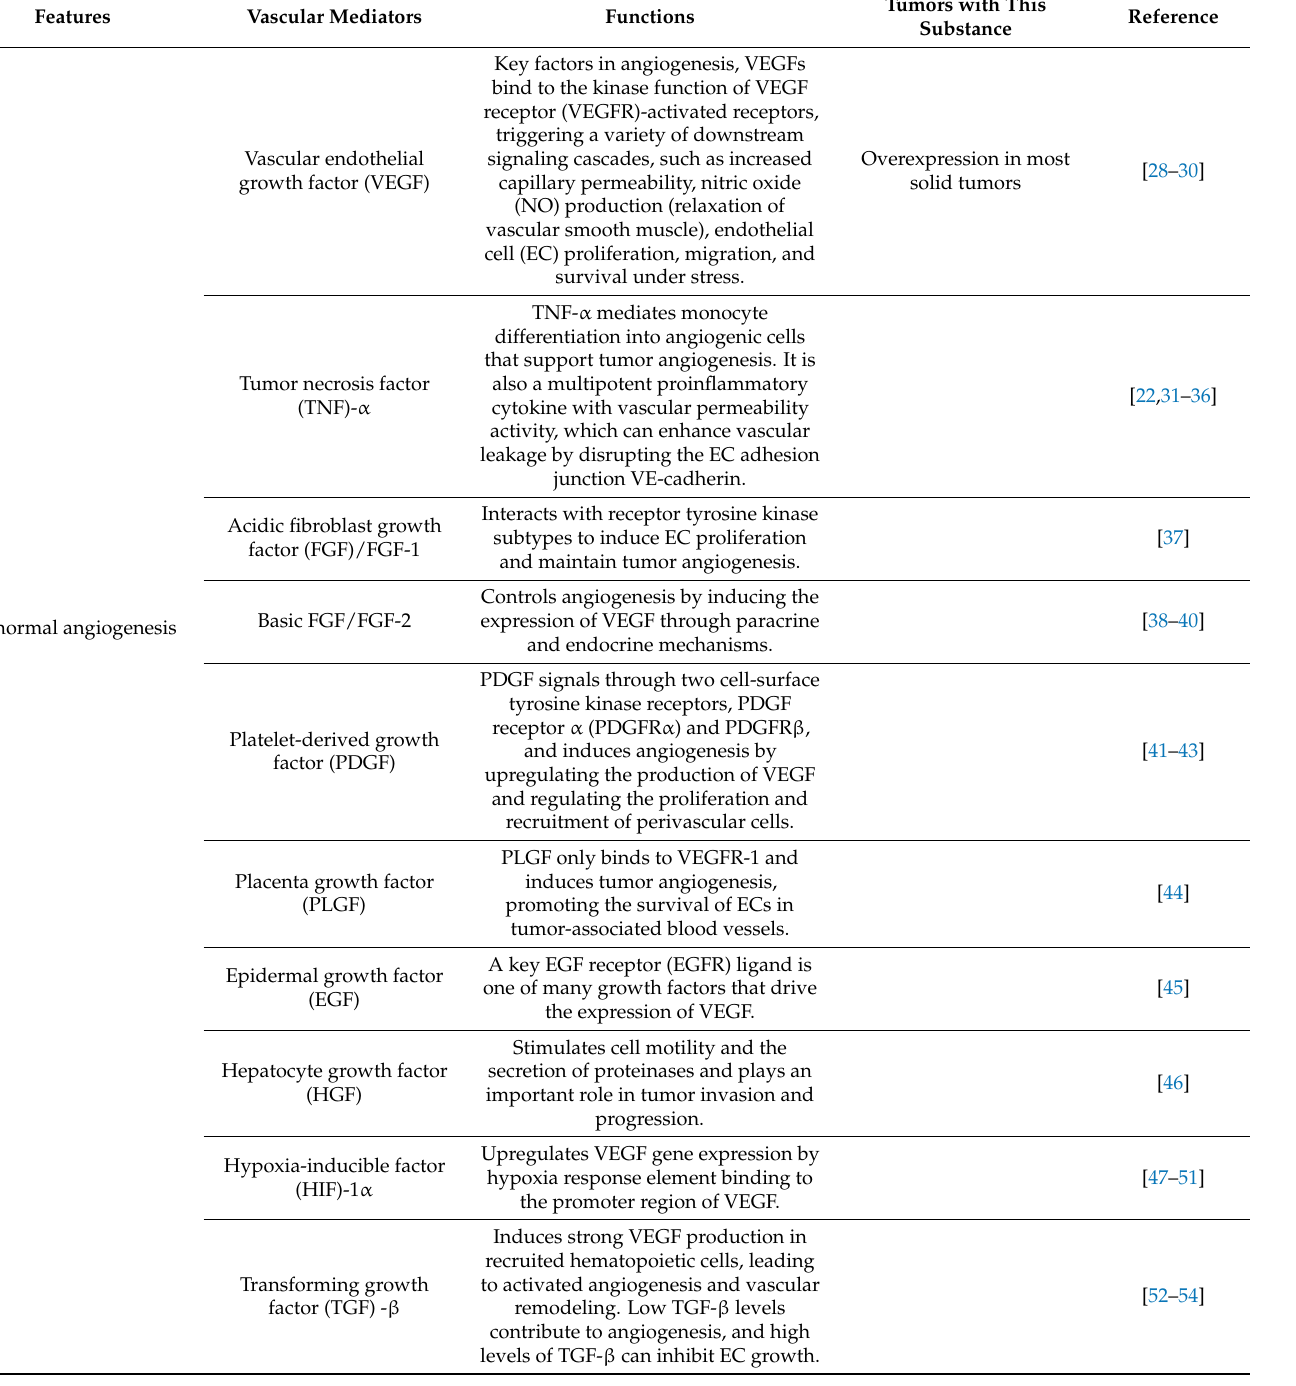
Table 1. Relationship between tumor vascular-related mediators and three typical vascular